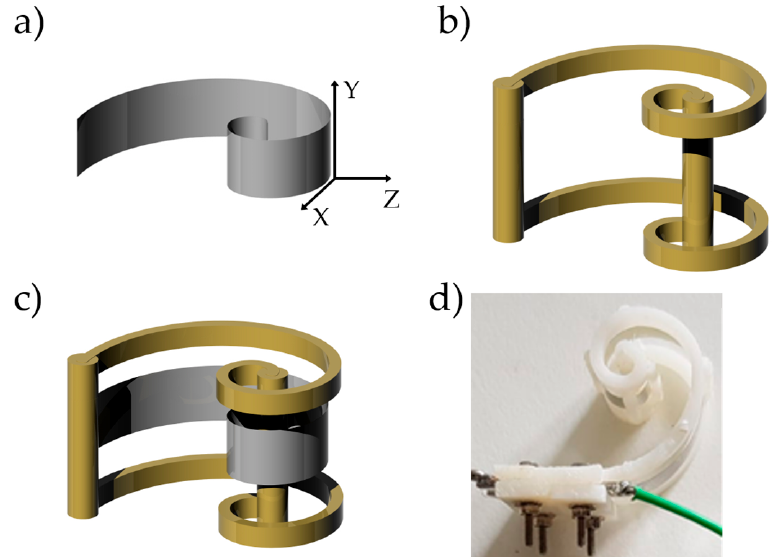
Figure 4. Fabrication of ultrasonic transducer which includes ( a ) a 3D printed Acrilonitrile butadiene stirene (ABS) support, and ( b ) a sheet of PVDF whose piezoelectric direction is properly oriented. The latter is finally inserted inside the slits of the support before being mechanically and electrically connected to the ( c ) support and the electronic interface. Representative fabrication of one of the ( d ) proposed spiral